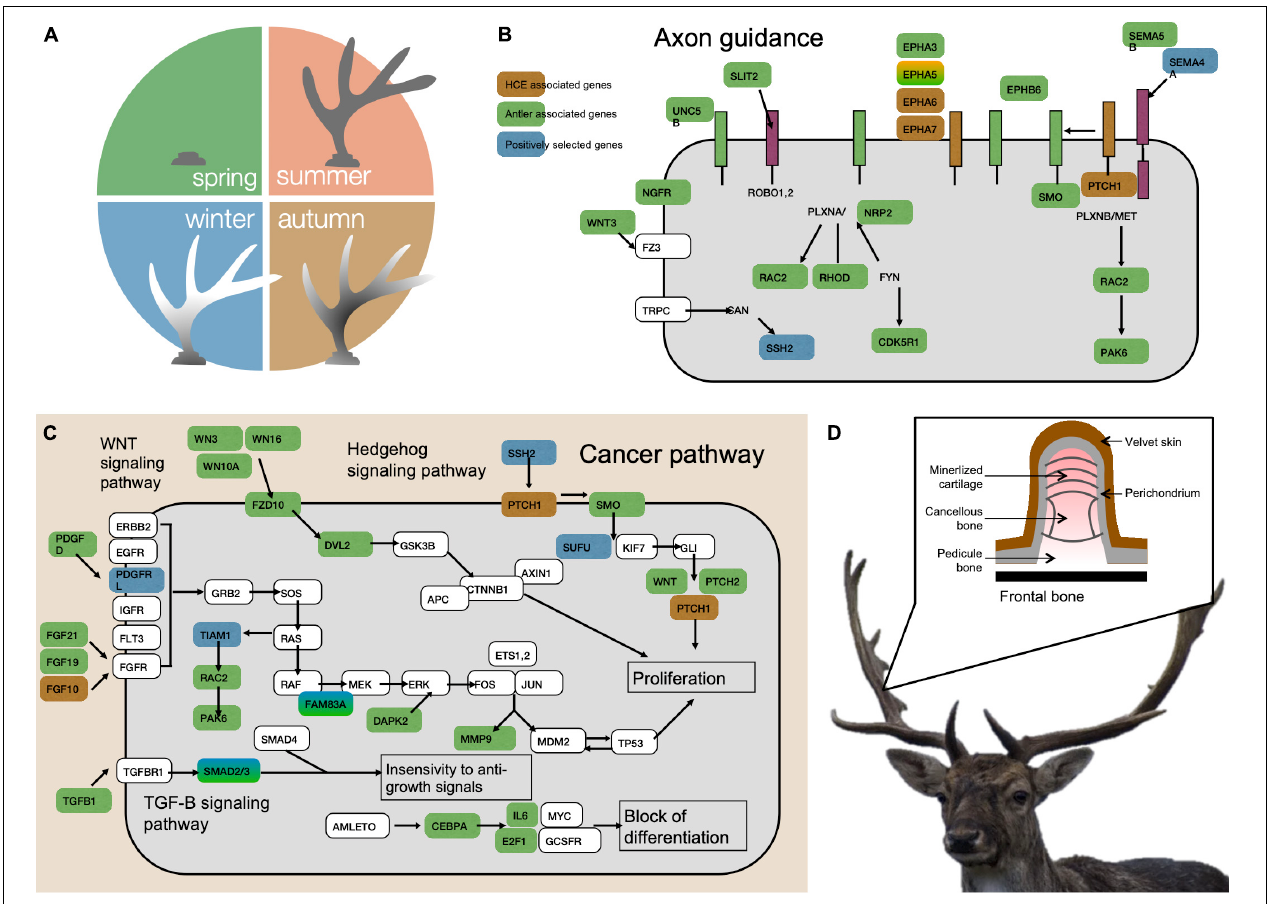
FIGURE 3 | Antler regeneration, neurogenesis and oncogenesis pathways. (A) Annual antler regeneration cycle in red deer. Antlers, after shed in winter regenerate in spring, and then grow most rapidly in summer. In autumn, they calcify and shed their velvet. For (B) (Axon guidance pathways) and (C) (Oncongenesis pathways): blue, genes positively selected in cervids; yellow, cervid-specific HCE associated genes; green, antler-specific expression genes. (D) Antler anatomy. (C) The anatomy of the antler. The source and credit for the red deer: Pixabay. Figure modified from Wang et al.